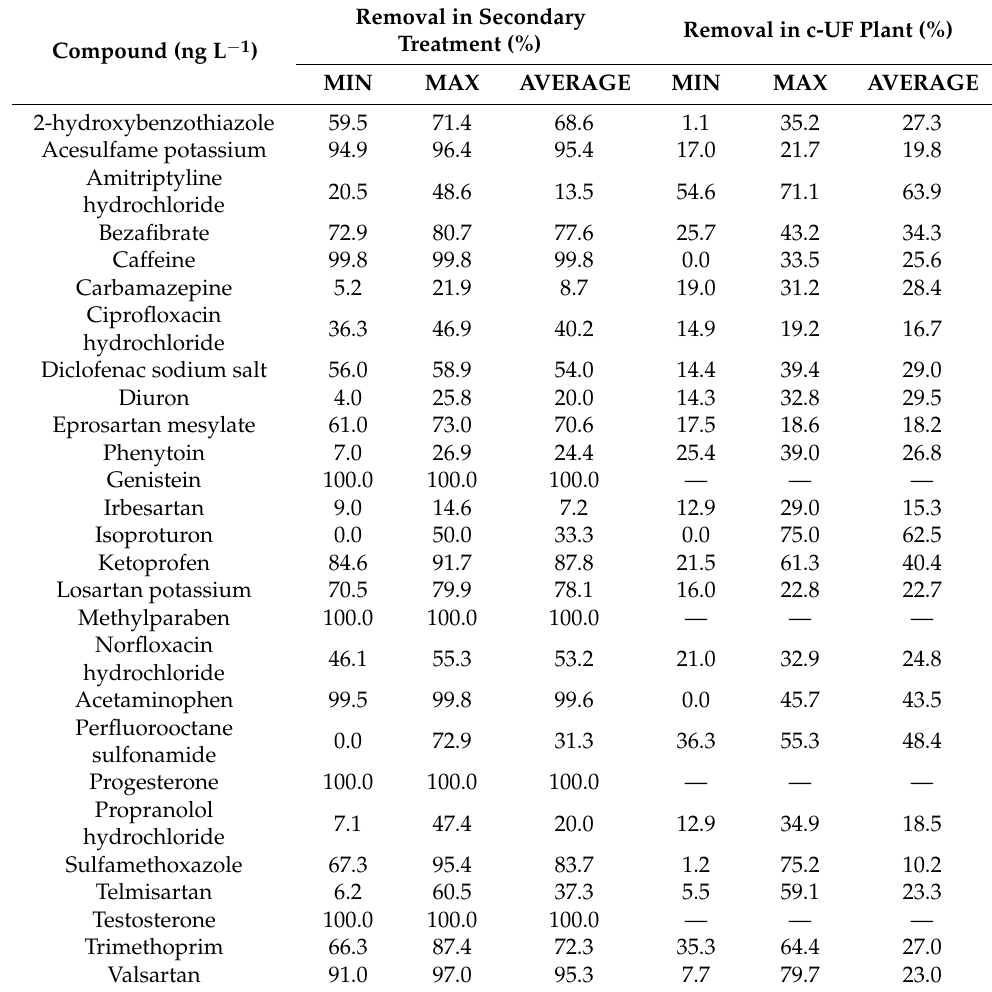
Table 4. Removal yields of the different CECs in the secondary treatment and through the c-UF pilot plant with a self-cleaning